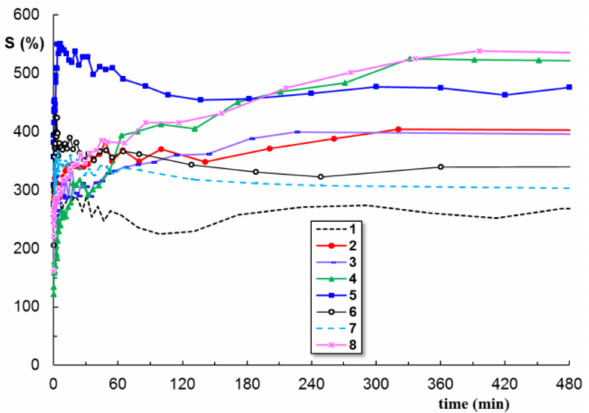
Figure 8. Swelling kinetics in PBS for different hydrogels (Table 1) at 37 ◦ C and pH =